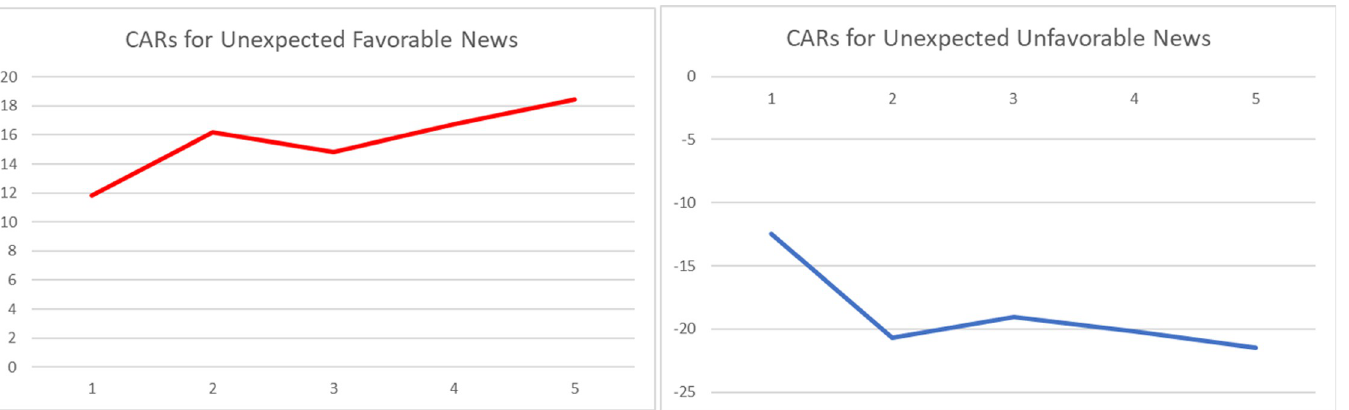
PLOS ONE | https://doi.org/10.1371/journal.pone.0264522 March 10,